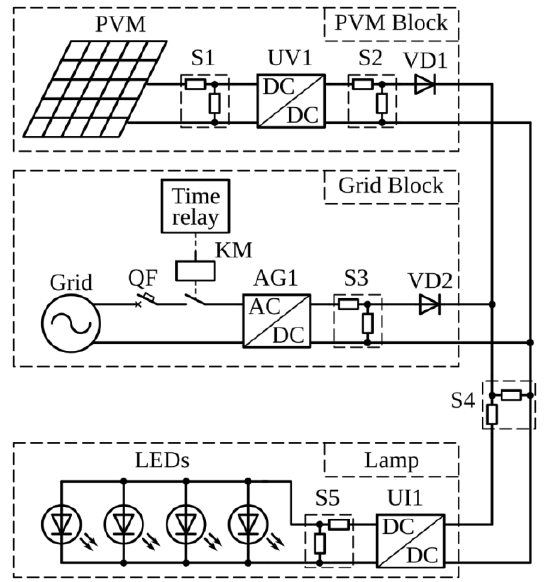
Figure 2. Electrical schematic diagram of a lighting system with a parallel power supply from photovoltaic modules and the power grid: (UV1) step-up converter QSKJ QS-1224CCBD; (AG1) power supply unit XD-DC 2425; (UI1) current stabilizer (step-down converter) QSKJ QS-2405CCBD; (S1 . . . S5) current and voltage sensors INA226; (VD1 . . . VD2) Schottky diodes 90SQ045; (QF) circuit breaker; (KM) contactor. Table 1. Main characteristics of equipment for a lighting system with parallel power supply from photovoltaic modules and the power grid.